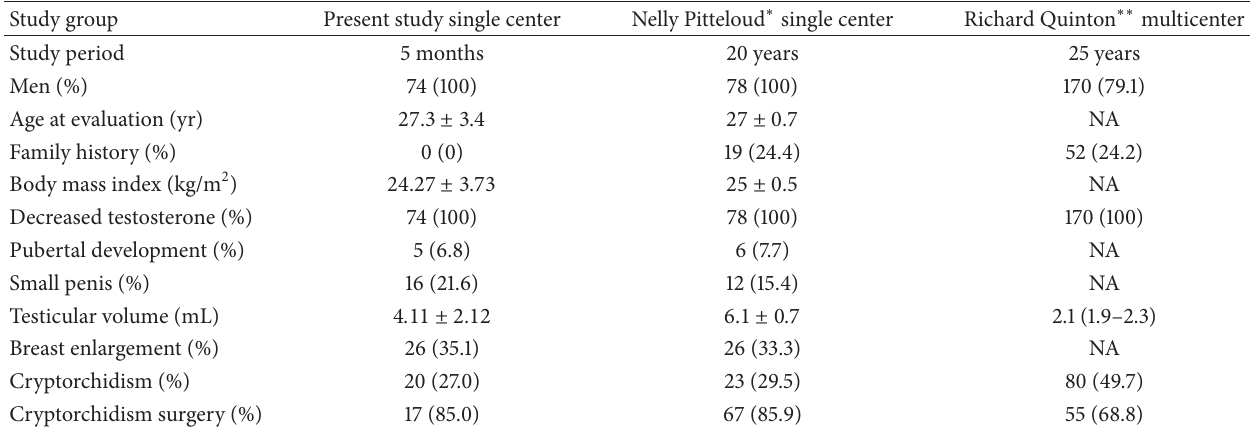
Table 2: Comparison of general characteristics of IHH patients between the present network investigation and studies reported in the